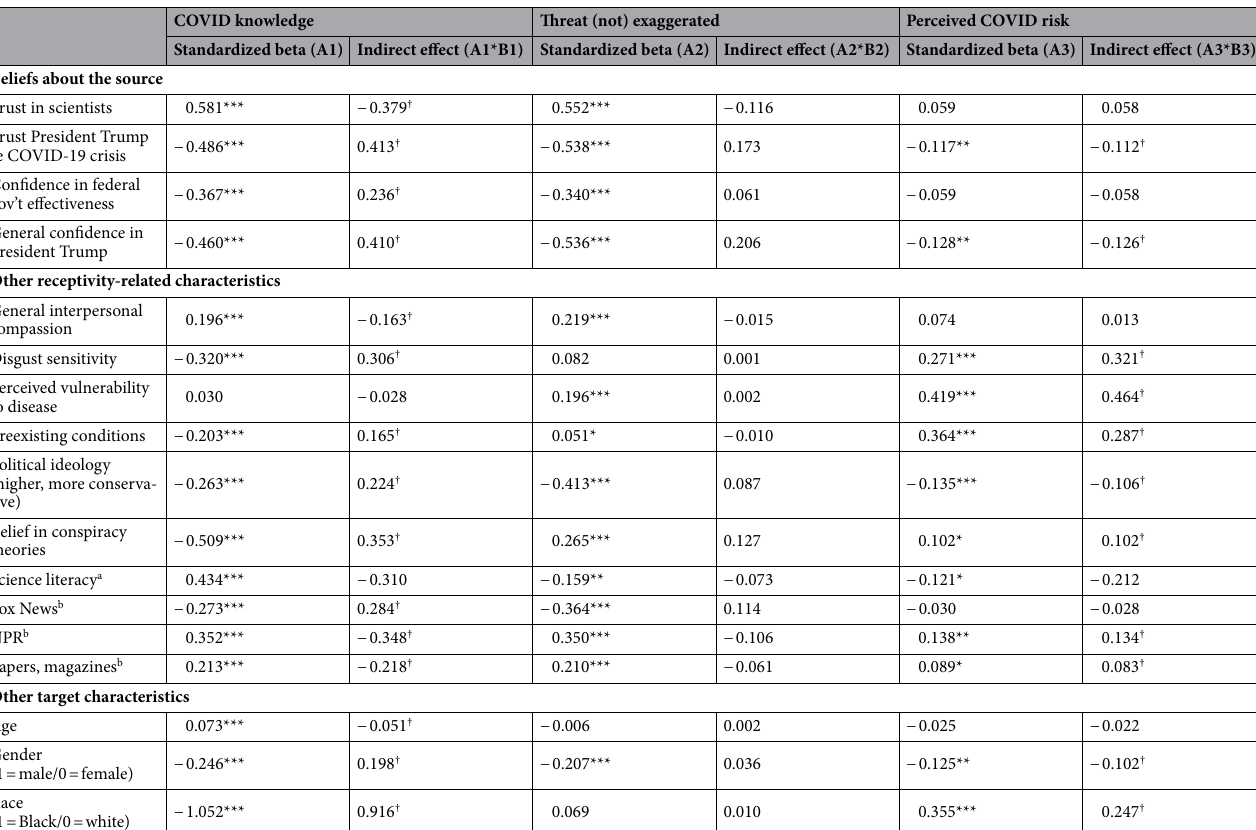
Table 2. Indirect effects of individual difference variables on testing positive for COVID-19 via COVID- specific variables. a Statistics for this variable should be interpreted cautiously as the bootstrapped mediational model failed to converge, presumably due to the small number of positive test cases (5 out of 304). b Coded 0 = neither watch last week, nor primary news source, 1 = watched last week or primary, 2 = both. * p < .05; ** p < .01; *** p < .001. † Denotes a 95% bias-corrected bootstrap confidence interval (using 10,000 bootstrap samples) that does not include